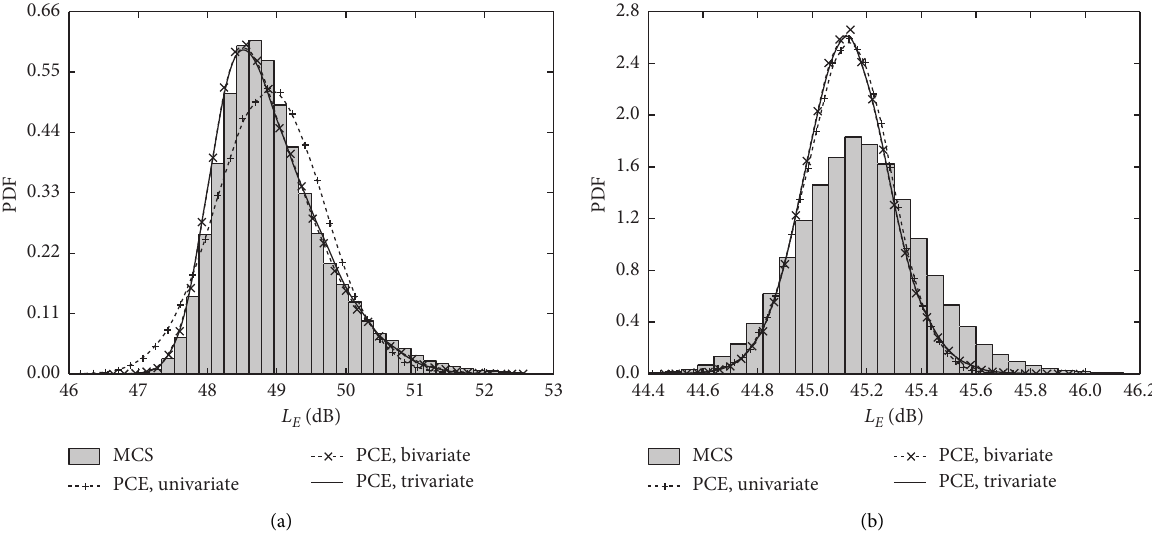
Figure 7: PDFs of the energy-level response of the 1/3 Oct spectrum. (a) f